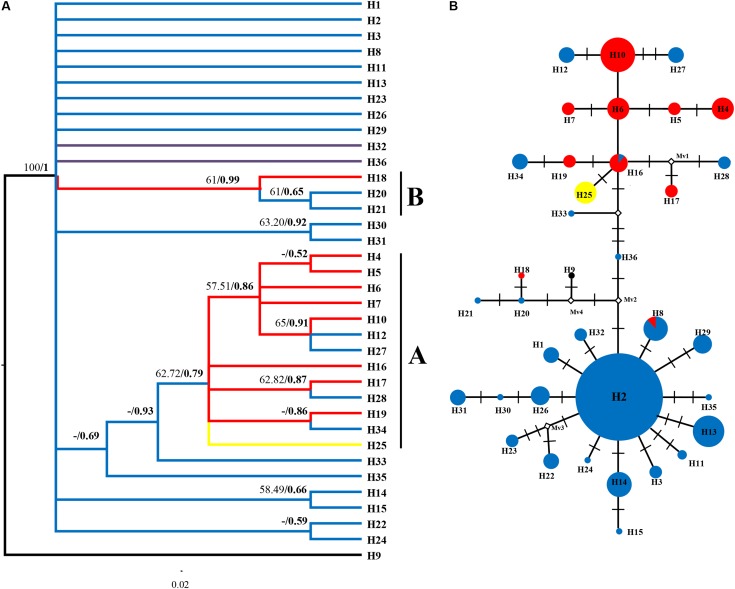
Phylogenetic relationships based on cpDNA haplotypes. (A) The Bayesian tree topology of the 36 cpDNA haplotypes detected in R. fastigiata. Numbers above the branches are MP bootstrap support values (left) and Bayesian posterior probability (right). Different branch color represents geographic groups defined by the SAMOVA analysis. H9 represents outgroup sequence of R. coccinea. (B) NETWORK-derived genealogic relationships. The sizes of the circles in the network were proportional to the observed frequencies of the haplotypes in each population. The white diamonds represent missing chlorotypes. Different color of circles represents geographic groups defined by the SAMOVA analysis.